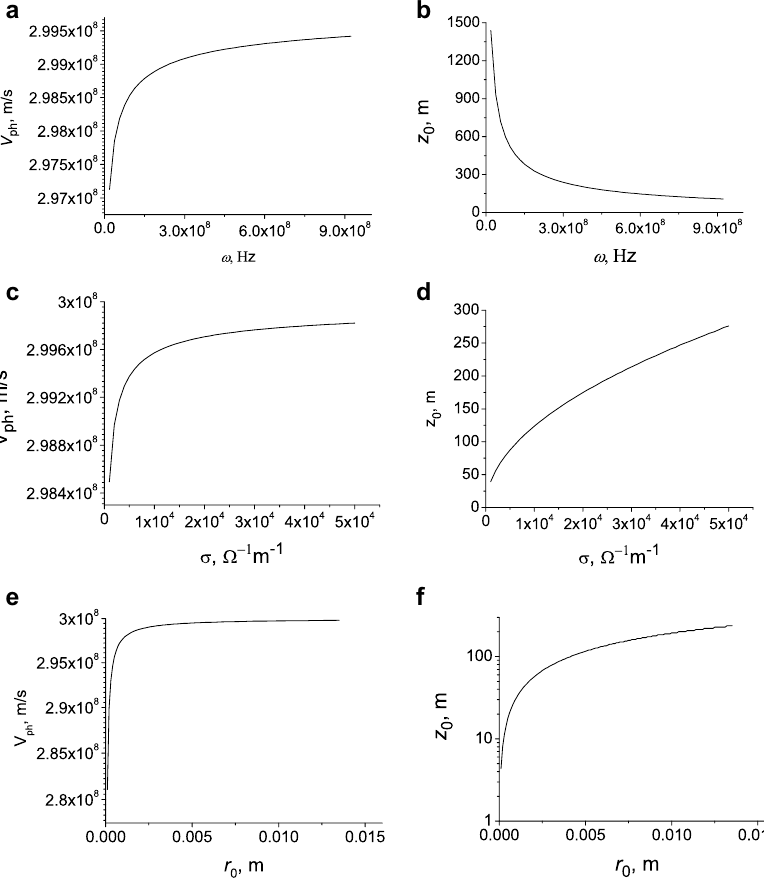
Figure 1. Velocity (panels a, c and e) and attenuation length (panels b, d and f) as function of frequency ( a , b ), conductivity ( c , d ) and channel radius ( e , f ). ( a , b )-σ = 10 4 (cid:31) −